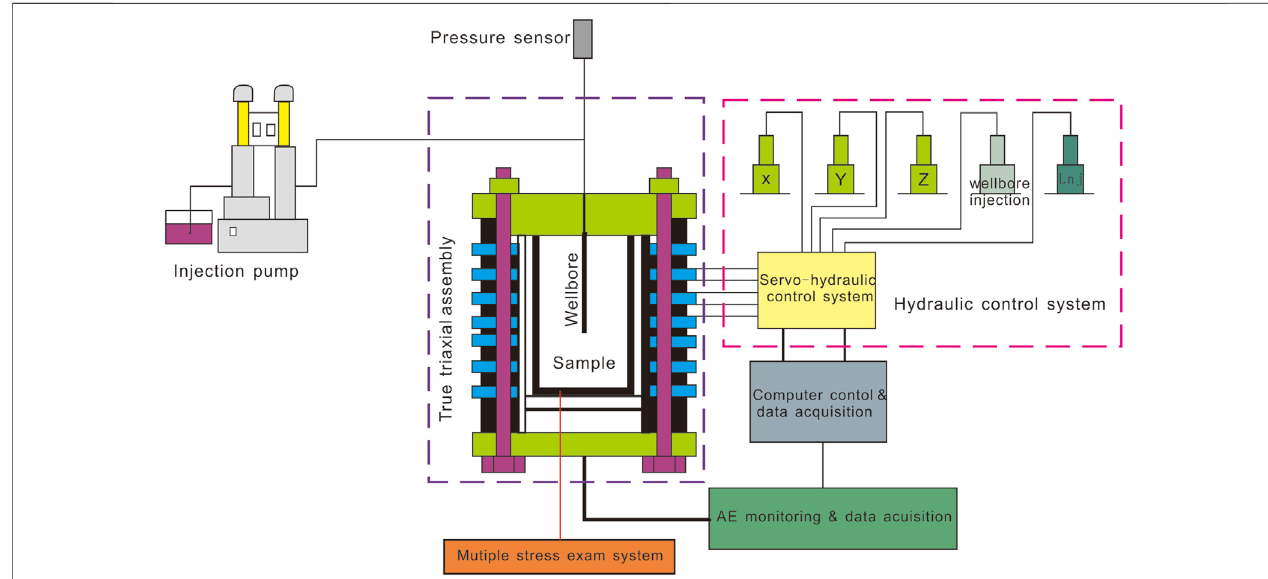
FIGURE 1 | Schematic diagram of the true triaxial hydraulic fracturing system.